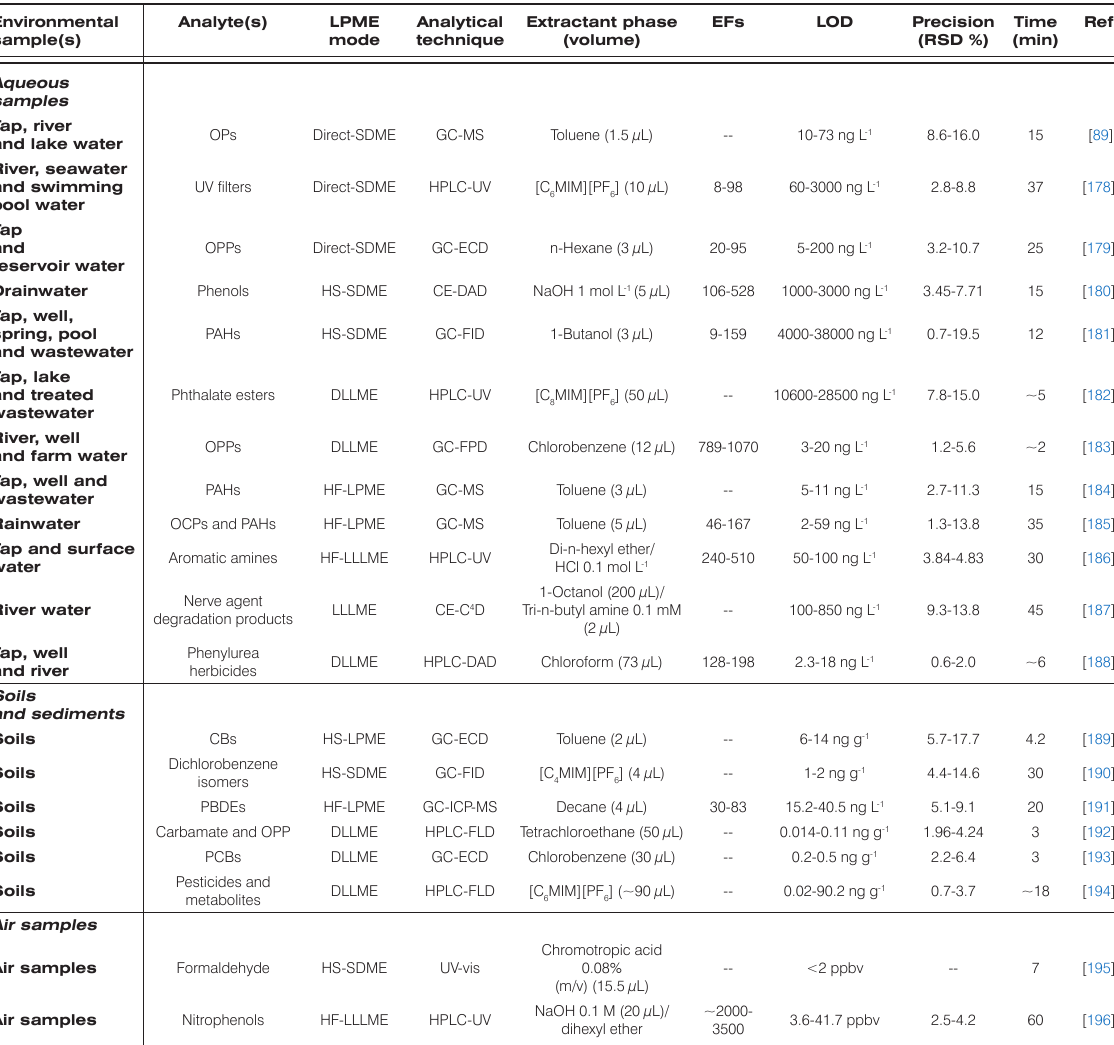
Table 2. Selected applications of LPME to the determination of organic compounds in environmental